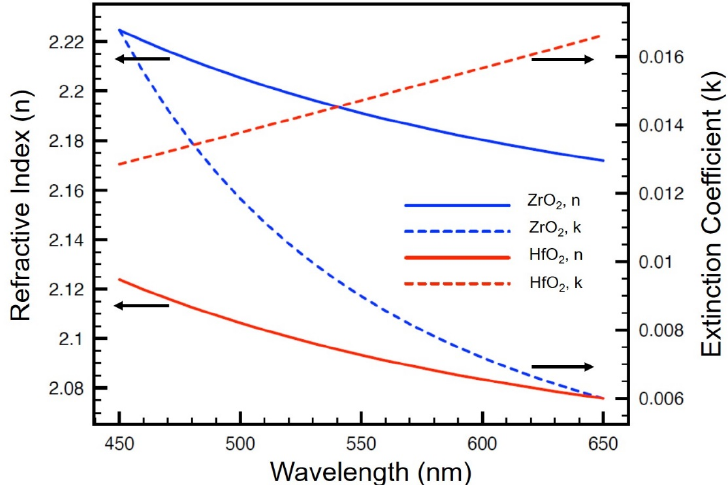
Figure 8. Refractive index and extinction coe ffi cient of the HfO 2 and ZrO 2 thin films versus wavelength.